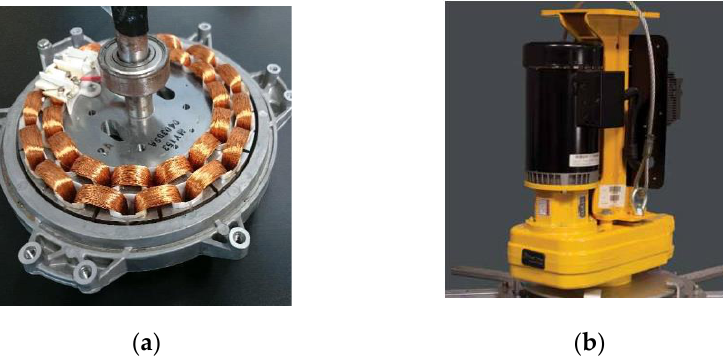
Figure 5. Induction Motor Technologies Induction Motor architecture ( b ) AC Induction Motor